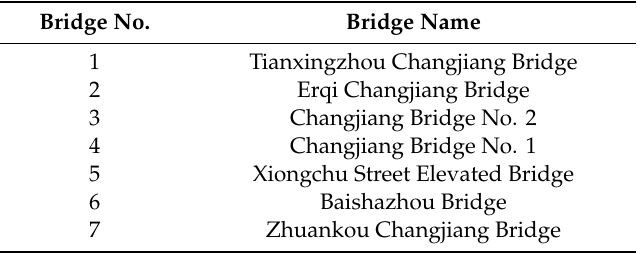
Table 1. Name and number of the seven bridges investigated in this paper. See locations in Figure 1b. Bridge No. Bridge